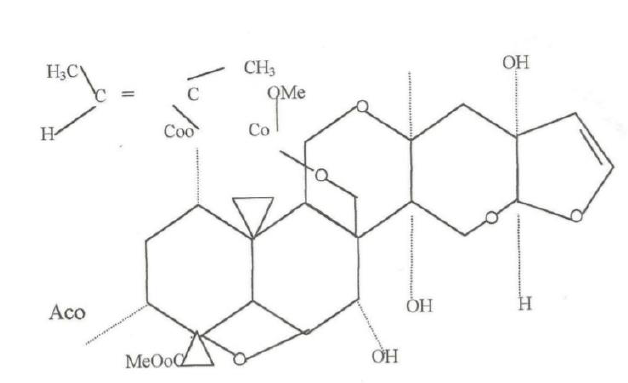
Fig. 1. The chemical structure of a primary component found in Azadirachta indica (neem) seeds